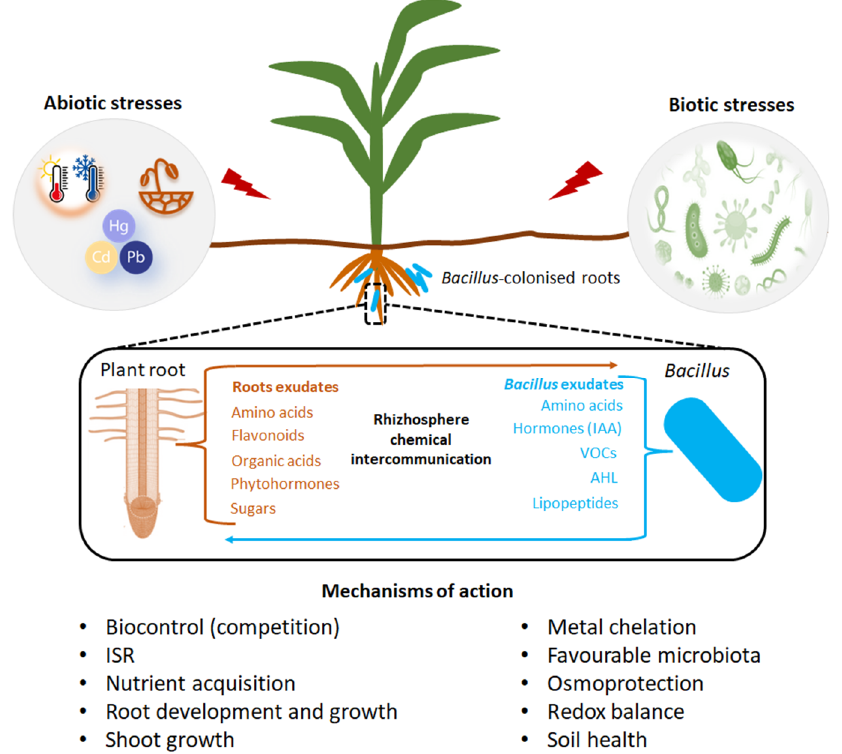
Figure 3. An overview of mechanisms employed by Bacillus spp. in the mitigation of biotic and abiotic stresses. Bacillus produce cyclic lipopetides which activate pathways regulated by jasmonic acid and ethylene and thus elicit induced systemic resistance (ISR). They also produce hydrogen cyanide (HCN) and the enzyme 1-aminocyclopropane-1-carboxylate (ACC) deaminase which lower the levels of plant ethylene. Siderophores produced by Bacillus chelate iron thus making it unavailable to the pathogen. Several root associated Bacillus spp. bacteria produce zeatin, gibberellic acid (GA), indole-3-acetic acid (IAA), salicylic acid (SA), abscisic acid (ABA) as well as volatile organic acids (VOCs) which help plants to withstand stress by enhancing its antioxidant potential, by up-regulation of the antioxidant system and by accumulation of compatible osmolytes thus reducing oxidative stress-induced damage; improving photosynthetic capacity and membrane stability; promoting cell division and stomatal regulation; stimulating growth of root system, and acquisition of water and